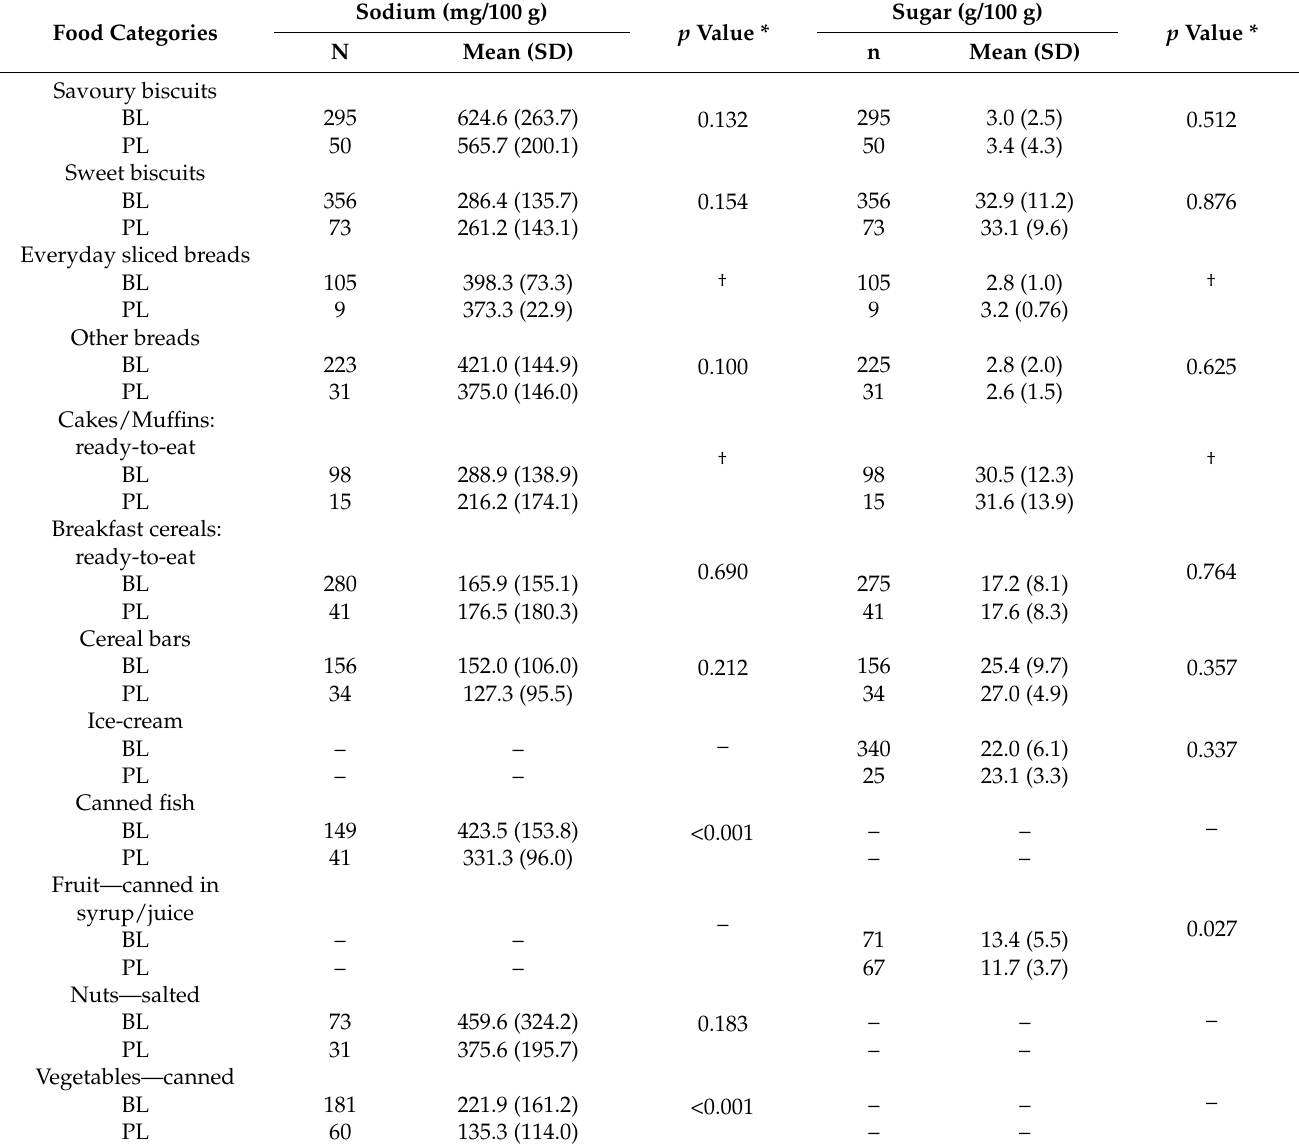
Table 1. Mean (standard deviation) of sodium and sugar content of branded and private label supermarket products in 2019, by food category and